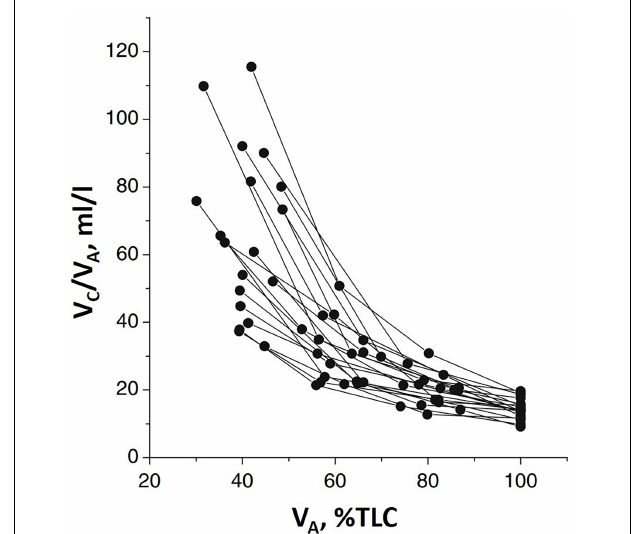
lung volume is expected the higher the number of alveoli.